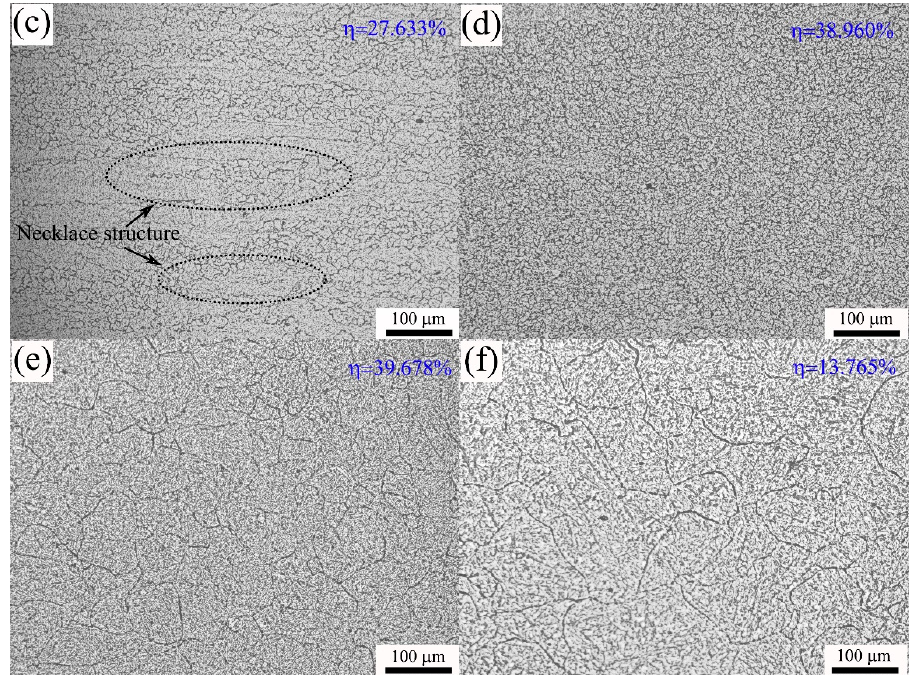
Figure 15. Typical microstructures of 70MnSiCrMo carbide-free bainitic steel after hot deforming at different temperatures and strain rates: ( a ) 1273 K/0.01 s − 1 ; ( b ) 1273 K/0.1 s − 1 ; ( c ) 1273 K/1 s − 1 ;